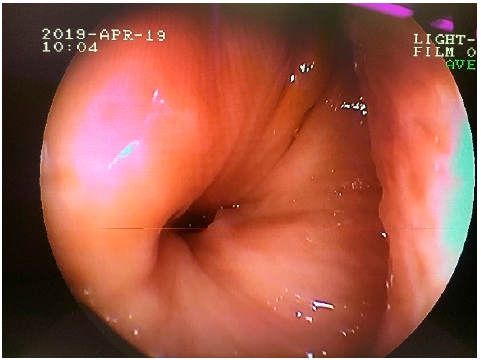
Figure 9. Transnasal endoscopic examination obtained 16 weeks after the initial surgery. Note the nasal opening of the persisted oronasal fistula at the level of 208 alveolus.